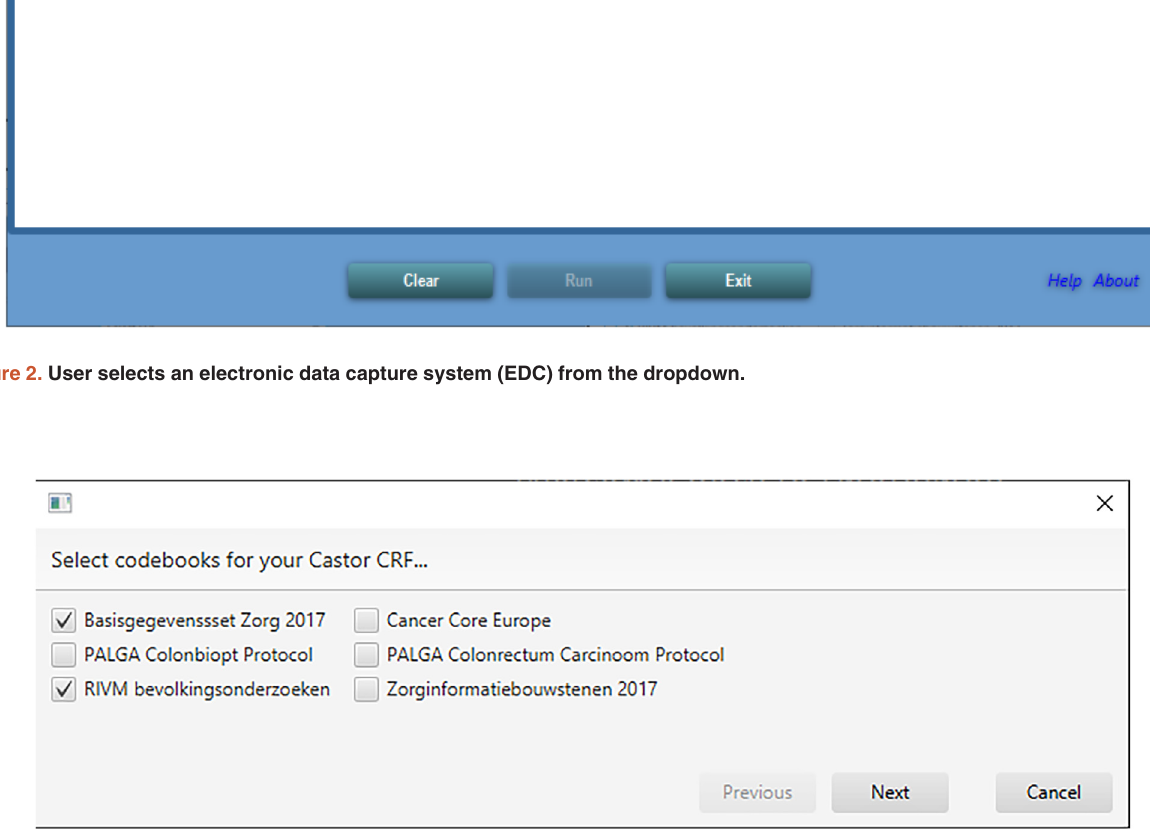
Figure 3. User selects one or more